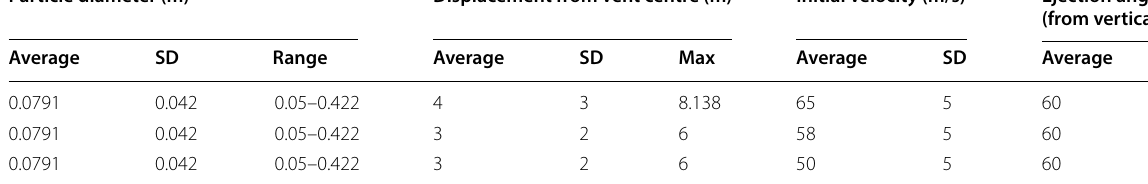
Flow velocity (m/s) range